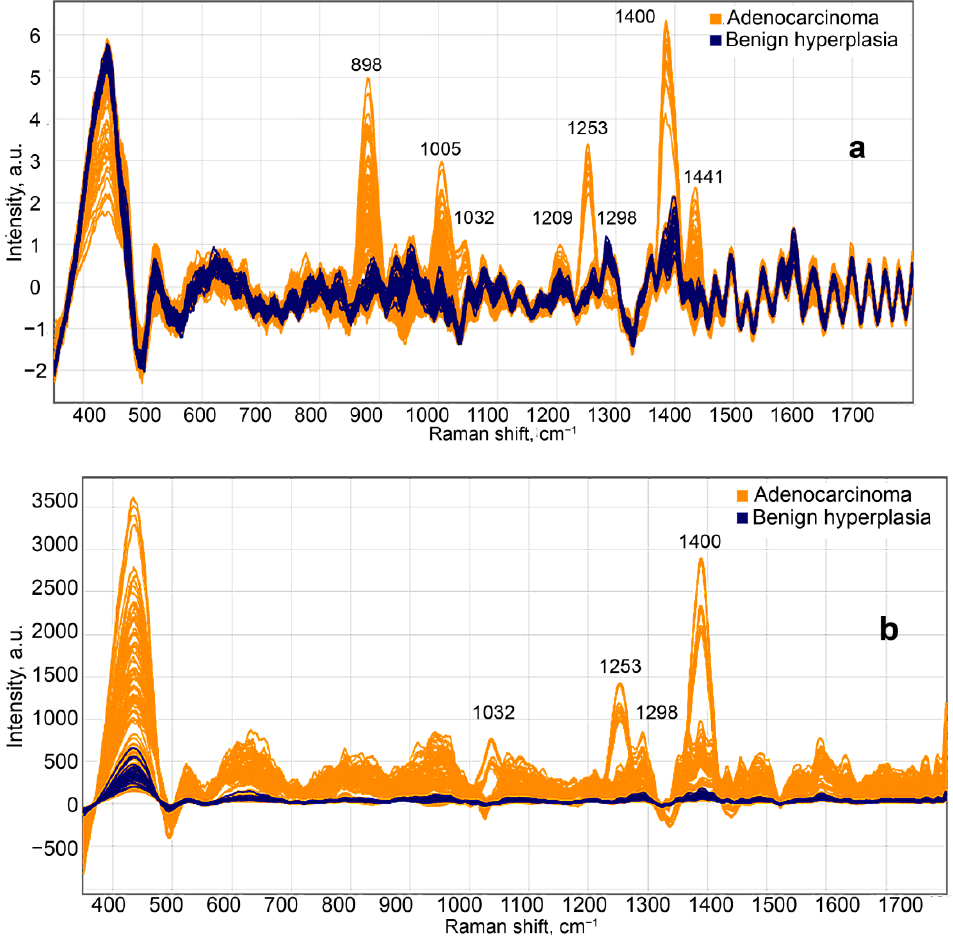
Figure 2. Preprocessed Raman spectra, using spectrum smoothing, background subtraction, and normalization ( a ) and the same combination of methods without normalization ( b ) from the regions of acinar adenocarcinoma and benign hyperplasia in prostatic tissue, produced by laser excitation of 785 nm